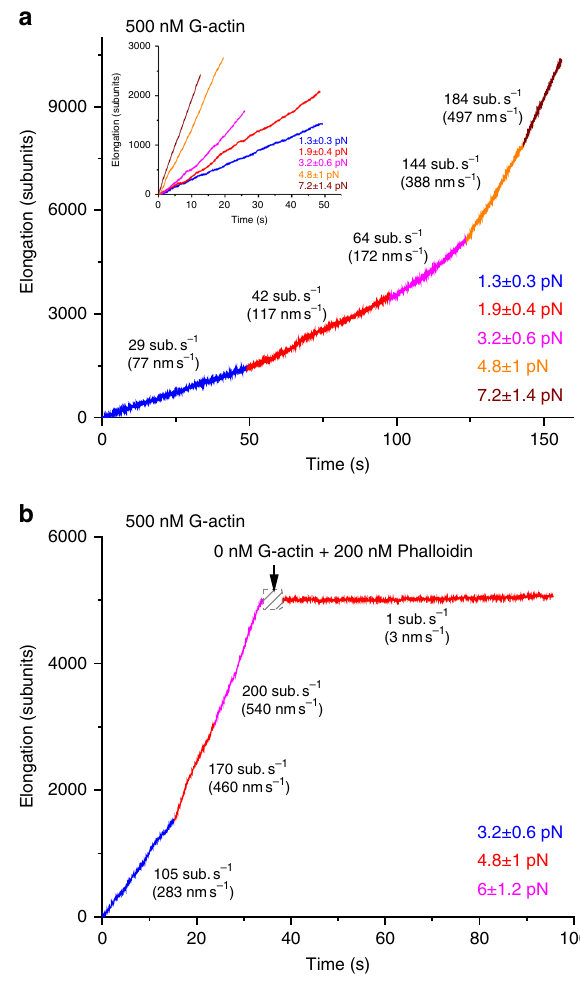
Fig. 2 Actin elongation speed is force-dependent. a Elongation trajectories of a single-F-actin fi lament in 500 nM G-actin solution under different forces. b The elongation of the F-actin fi lament stopped after free G-actin was washed off. The number of replication of the force-dependent actin polymerization at each force is indicated in Fig.